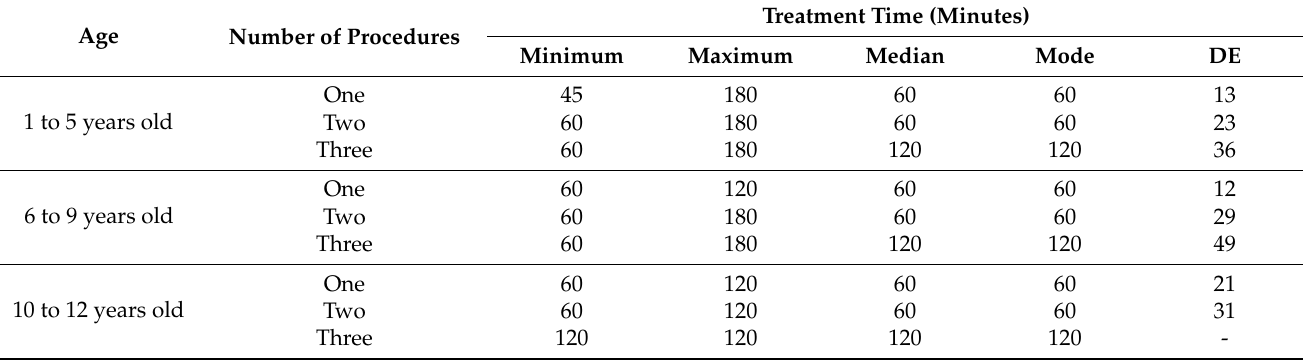
Table 2. Time according to age and number of